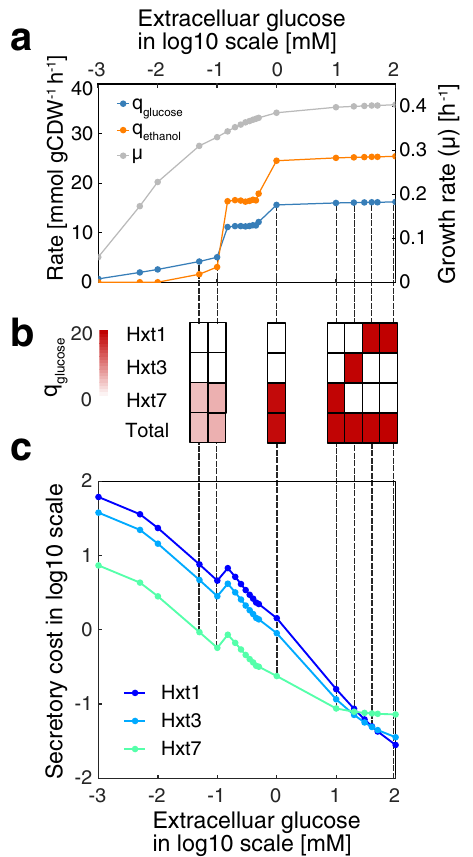
Fig. 2 Simulated physiological response of S. cerevisiae as a function of the extracellular glucose concentration. a Simulated glucose uptake rates, ethanol production rates and speci fi c growth rates under different extracellular glucose concentrations. Each point is the simulated result under a certain extracellular glucose condition. b Speci fi c glucose uptake rate carried by each glucose transporter and the total glucose uptake rate. Hxt1 and Hxt3 are two low-af fi nity glucose transporters, while Hxt7 is a high-af fi nity glucose transporter. c Calculation of secretory costs of different glucose transporters with the total glucose uptake rate at input for each extracellular glucose concentration, unit secretory cost, K M and k cat that are speci fi c to each transporter based on Eq. (1) in the Methods. Unit secretory cost is independent from the extracellular glucose concentrations and glucose uptake, while the secretory cost (y-axis) represents the cost for utilizing speci fi c glucose transporters to sustain speci fi c glucose uptake and the corresponding growth rate, respectively, which is a combination result of enzyme kinetics and total glucose uptake rate as described in Eq. (1). Source data are provided as a Source Data fi